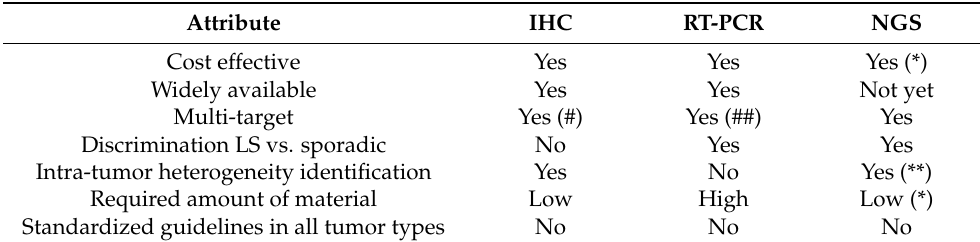
Table 1. Comparison between the main available tools for MSI/dMMR detection in solid tumors. Attribute IHC RT-PCR NGS Cost effective Yes Widely available Yes Not yet Multi-target Yes (#) Yes Discrimination LS vs. sporadic No Intra-tumor heterogeneity